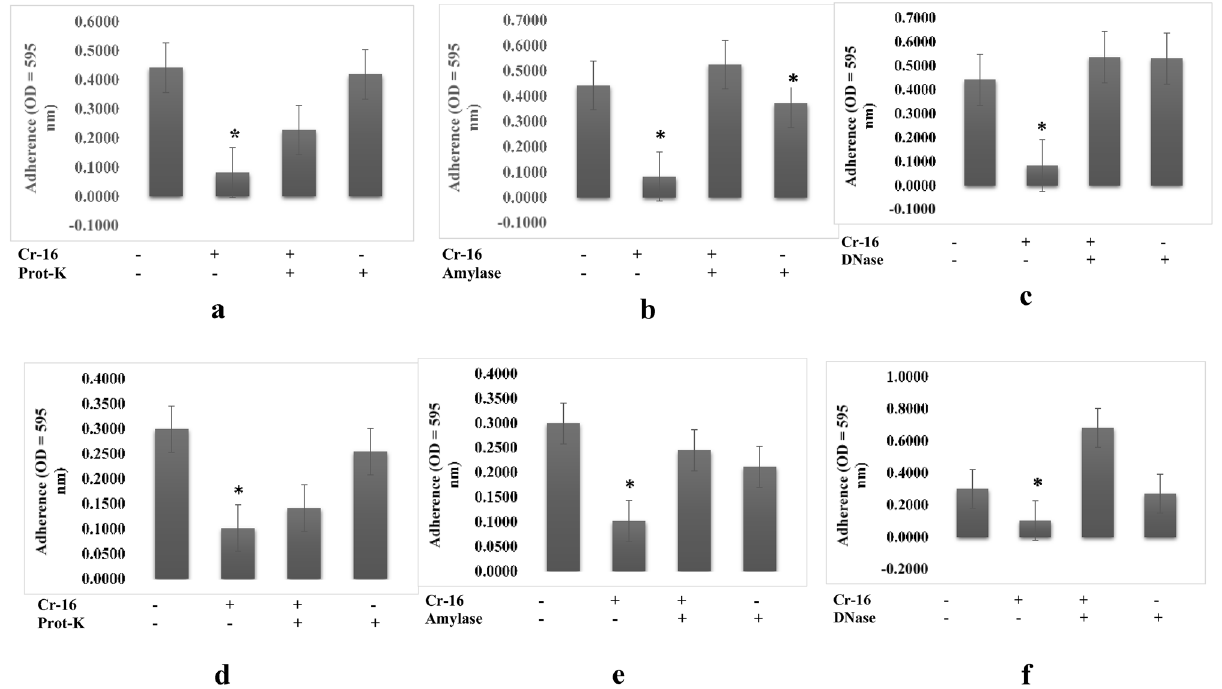
Figure 1. Characterization of extracts produced by 16PM isolate ( a – c ) which were responsible for the antibiofilm activity towards biofilm structure of A. hydrophila and ( d – f ) which were responsible for the antibiofilm activity towards biofilm structure of V. harveyi by treating the extract with amylase (1 mg/mL), proteinase K (1 mg/mL), and DNase I (100 mg/mL). (n = 6 replications; vertical bars are standard errors; *: significantly different at p <